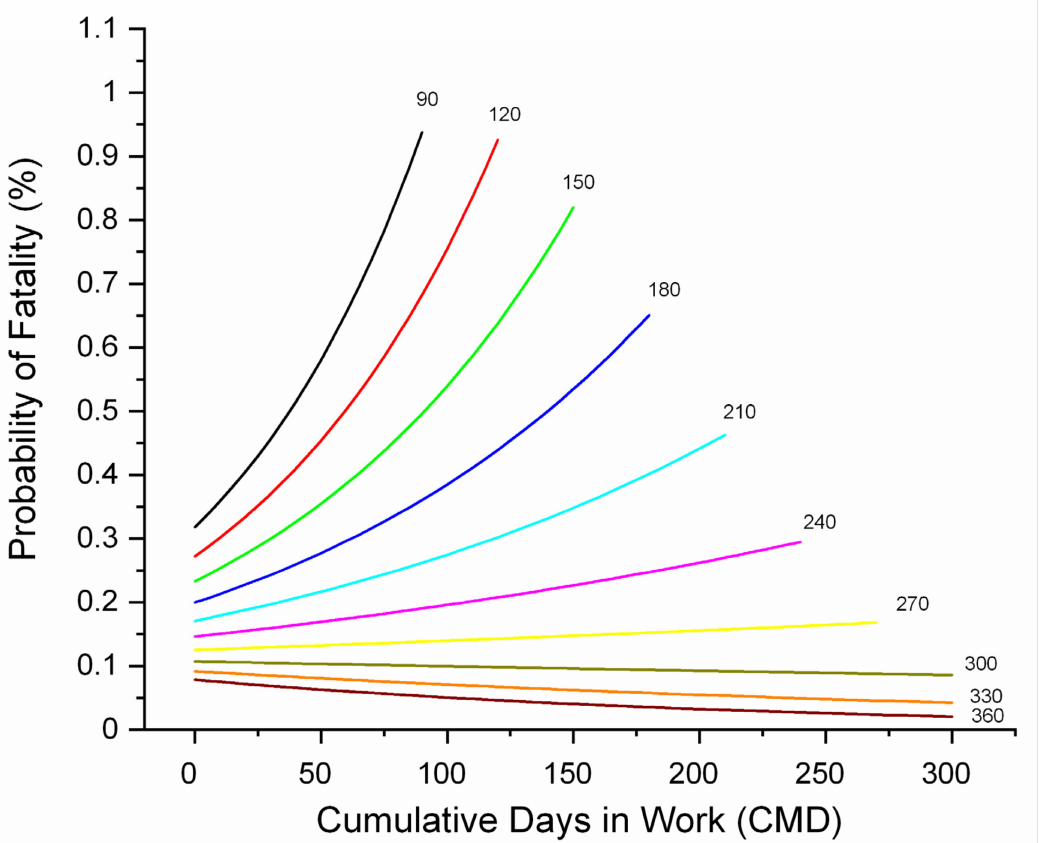
Figure 8. Probability of fatality (%) by cumulative days in work (CMD) and yearday (YD) and describing a CMD*YD inter- action identified during multivariable logistic regression modelling of associations with fatality for Ontario Thoroughbred racehorses for the period 2003–2015, unit of interest—race-event by horse-year. YD for each relationship is shown at the end of each curve. At the start of the season, probability is higher and there is a relatively rapid increase in fatality with increasing days in work, but as the season progresses, liability falls and the gradient of this relationship progressively decreases, then reverses. There was no second order relationship with